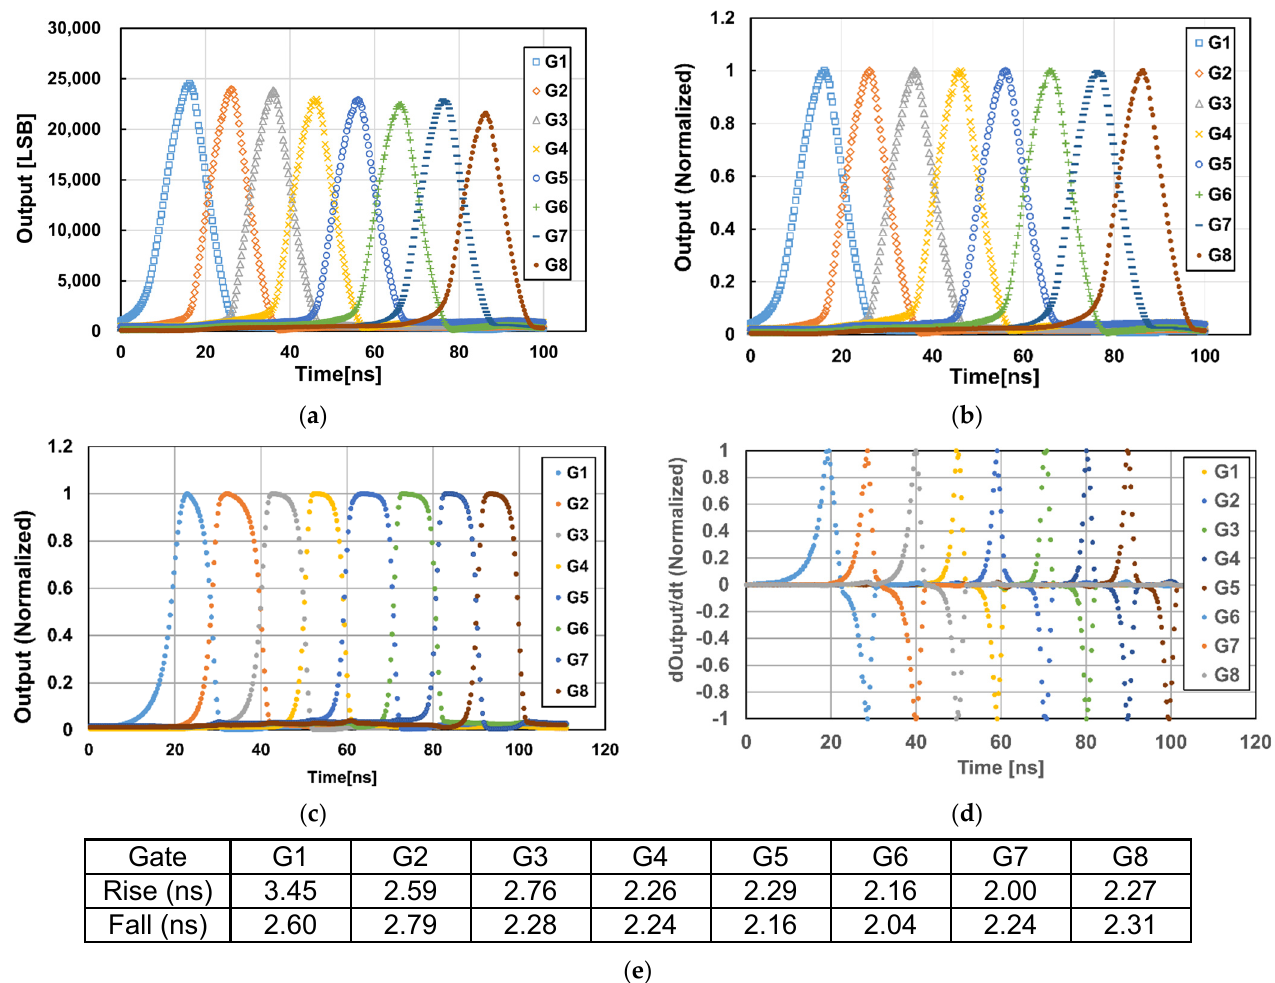
Figure 7. Response of the 8-tap outputs to the light pulse delay. ( a ) Response to Short Pulse (940 nm, T 0 = 10 ns). ( b ) Response to Short Pulse (T 0 = 10 ns, Normalized). ( c ) Response to Very Short Pulse (FWHM = 69 ps, 851 nm, Normalized). ( d ) Time Derivative of ( c ) by The Delay Time (Normalized). ( e ) FWHM of The Pixel Response to Very Short Pulse (FWHM = 69 ps) Measured with ( d ).